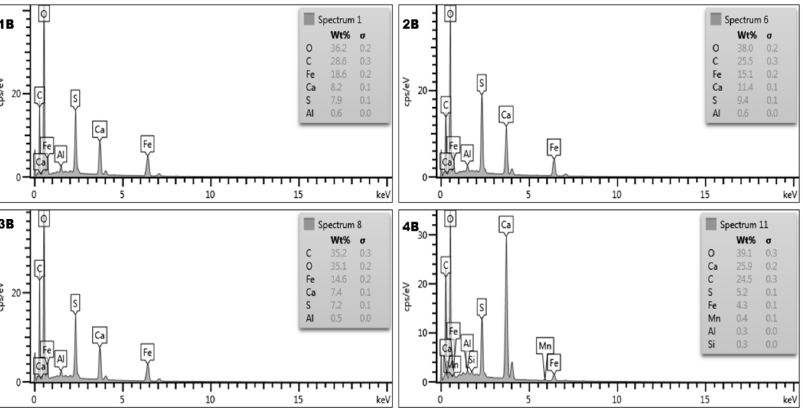
Figure 16. Energy dispersive spectroscopy (EDS) plots of nanoparticles samples produced from AMD. 1B = (25 ◦ C-CaCO 3 as alkali); 2B = Goethite (150 ◦ C-CaCO 3 as alkali); 3B = Goethite (300 ◦ C-CaCO 3